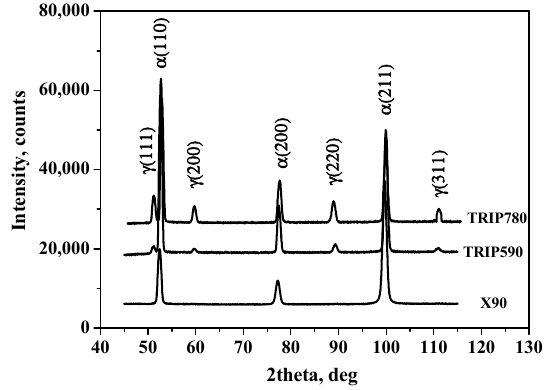
Figure 14. The measured XRD patterns for different steels ( α , ferrite or other phases with bcc structures; γ , retained austenite phase).